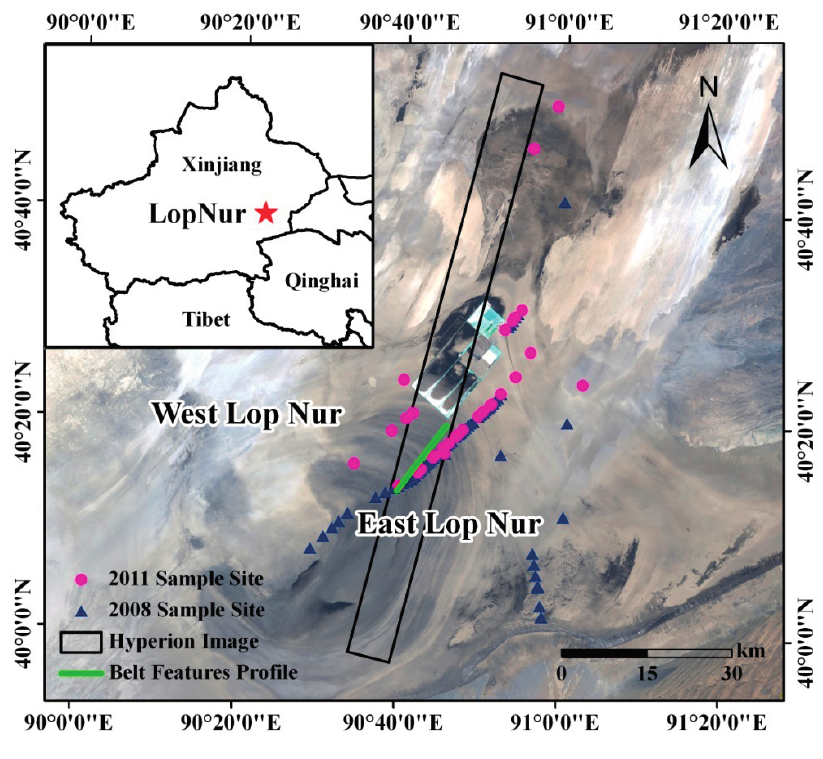
Figure 1. Study area and sampling sites in Lop Nur overlaid on a false color composite (TM 3 = red, TM 2 = green, TM 1 = blue) of the Landsat TM 5 image acquired on 23 August